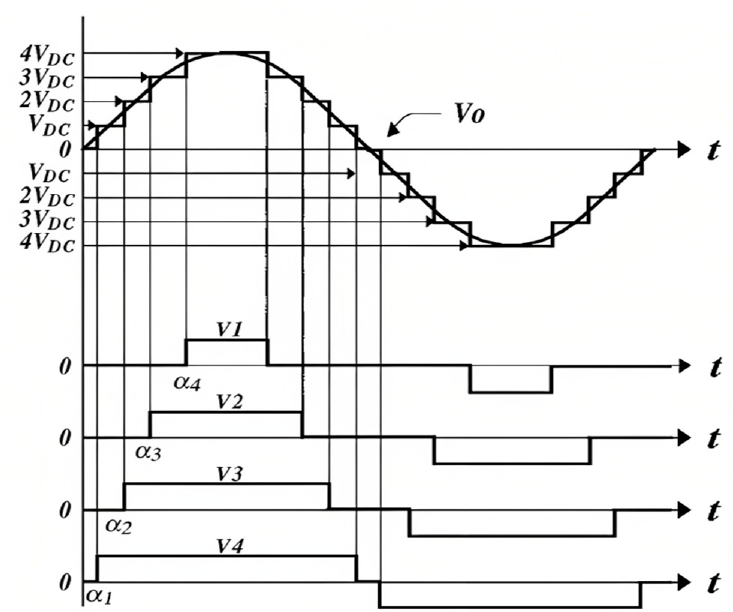
Figure 27. Cascaded H-bridge waveform.